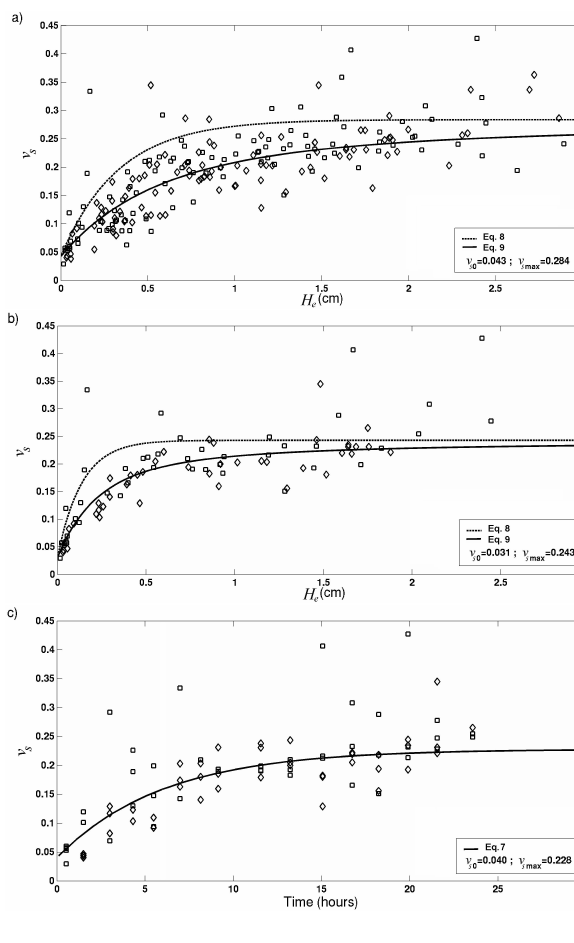
Fig. 10. Frazil volume fraction v s against equivalent frazil ice thick- ness H e : for (a) all experiment observations and (b) for E1. In (c) v s is shown for E1 against time, limited to 30 h growth. In each figure the solid curve shows the best fit of the exponential relations Eq. (7) (c) and Eq. (9) ( a and b ) to the data. The dashed curve in (a) and (b) is the corresponding Eq. (8), giving the maximum (surface) solid fraction implied by the compaction model. Observations for tank A are shown as squares, tank B as